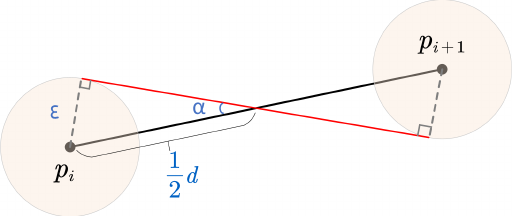
Figure 9. Offset angle caused by positioning